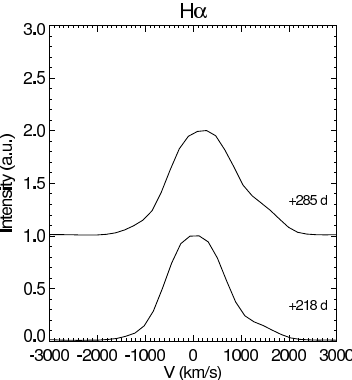
Figure 3: Line profiles of H α during the nebular stage (Poggiani,